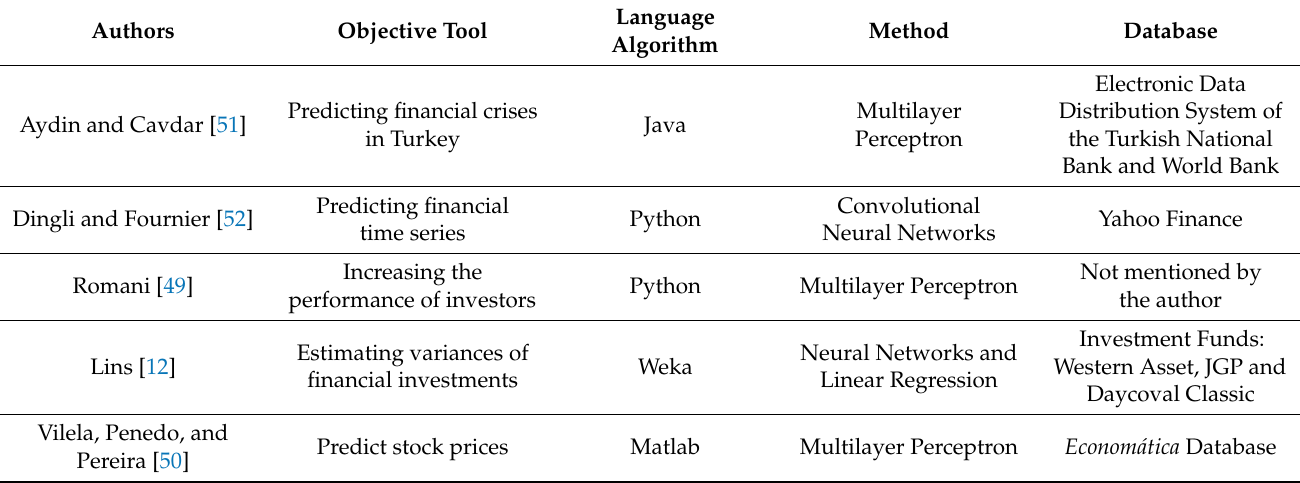
Table 1. Comparation of Related